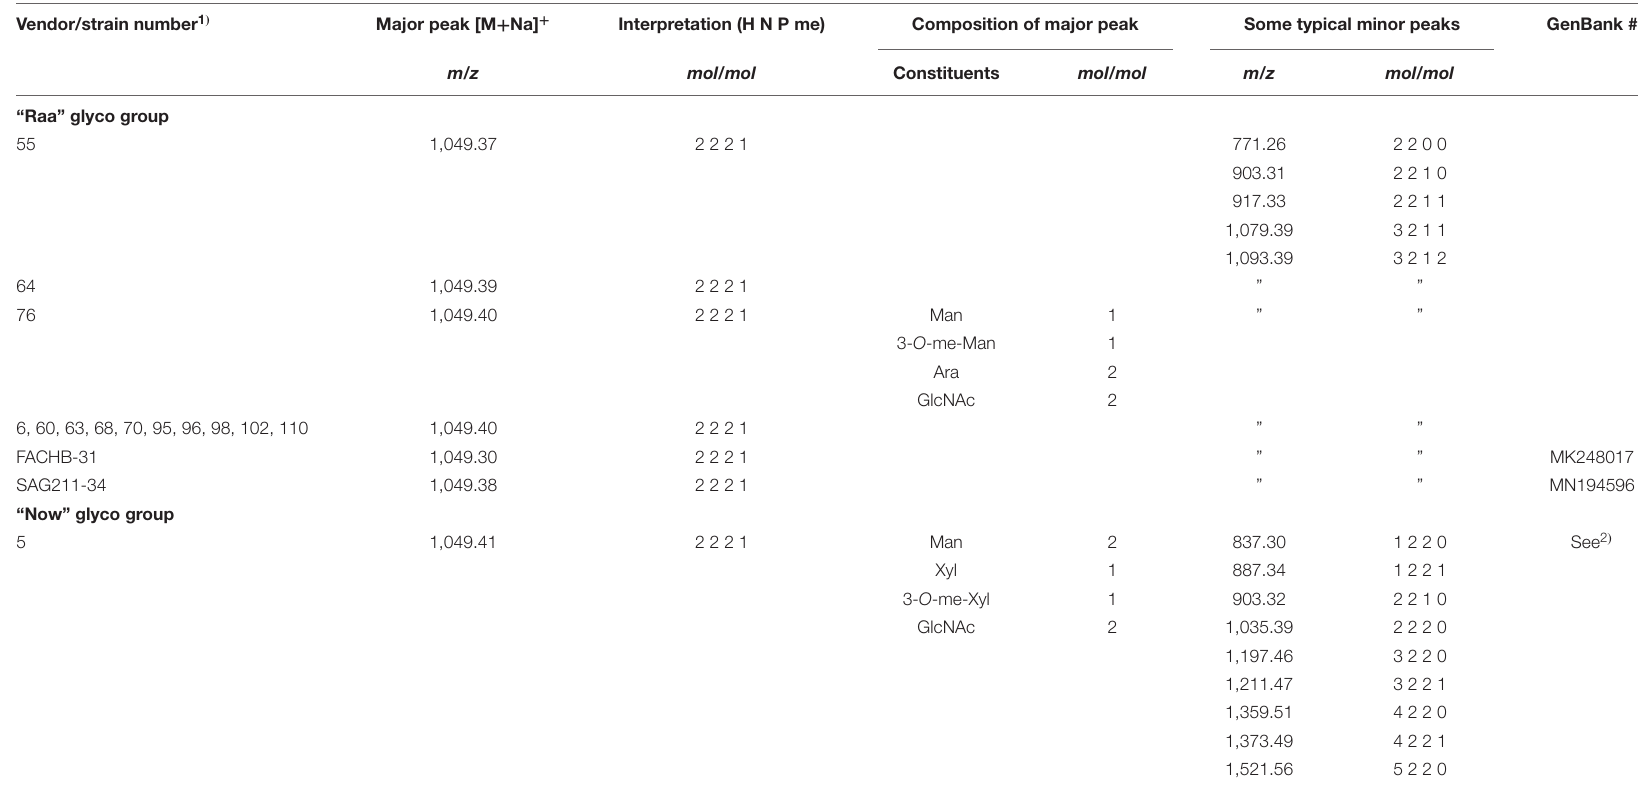
TABLE 1 | List of microalgae products for which a dominating peak at m/z = 1,049.365 (= calculated mass) in MALDI-TOF MS was